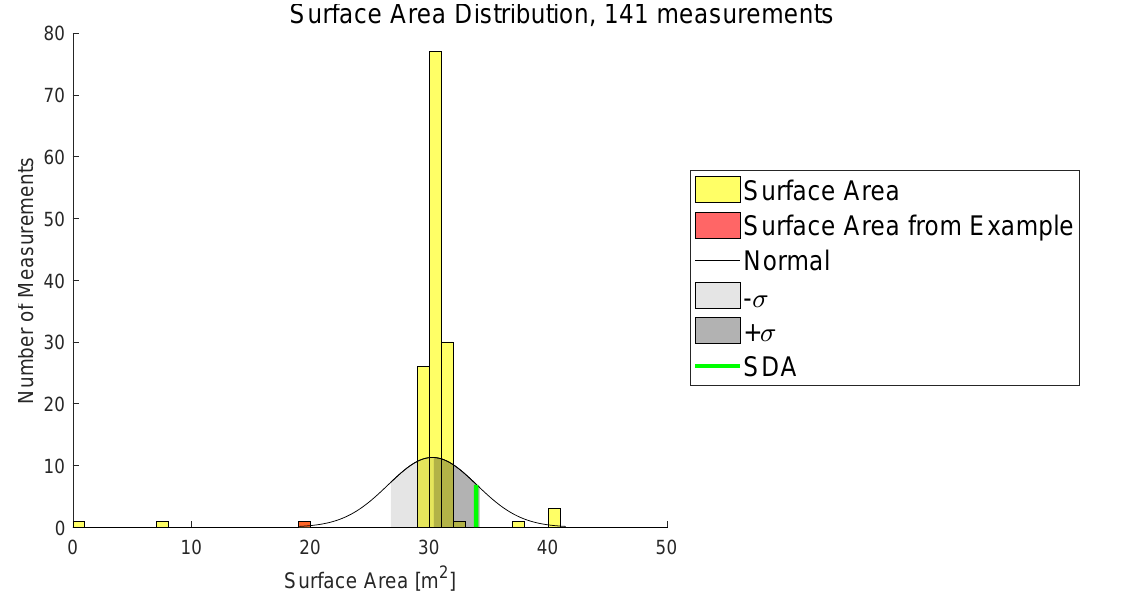
Figure 12. A distribution of the area of REDAs from 141 measurements of a selected test setup is shown in this